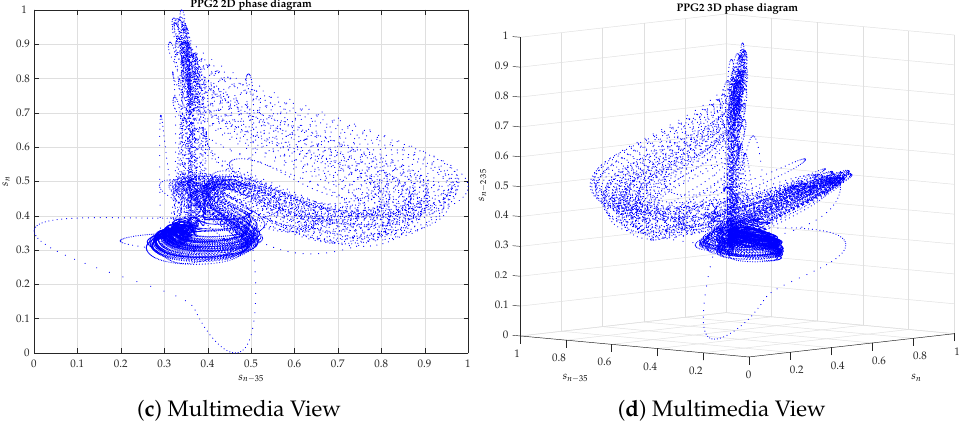
Figure A5. PPG signal of the healthy young Subject Number 2 (PPG2): ( a ) One minute PPG recorded signal. ( b ) PPG2 2D phase diagram with τ = 1. ( c ) PPG2 2D phase diagram with τ = 35, according to Table 1. PPG2 video clip of the evolution of phase diagram from τ = 1 to τ = 150 in 2D. ( d ) PPG2 3D phase diagram with τ = 35. PPG2 video clip of the evolution of phase diagram from τ = 1 to τ = 150 in 3D.